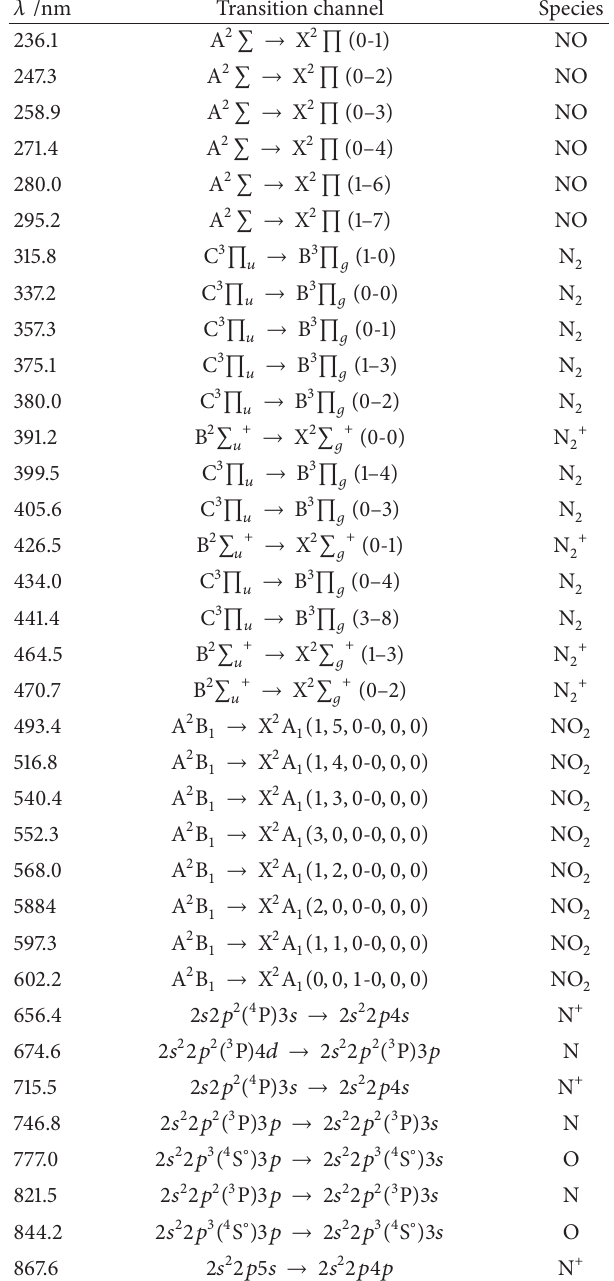
Table 1: Emission spectra and transition channel diagnosed from the NO emission